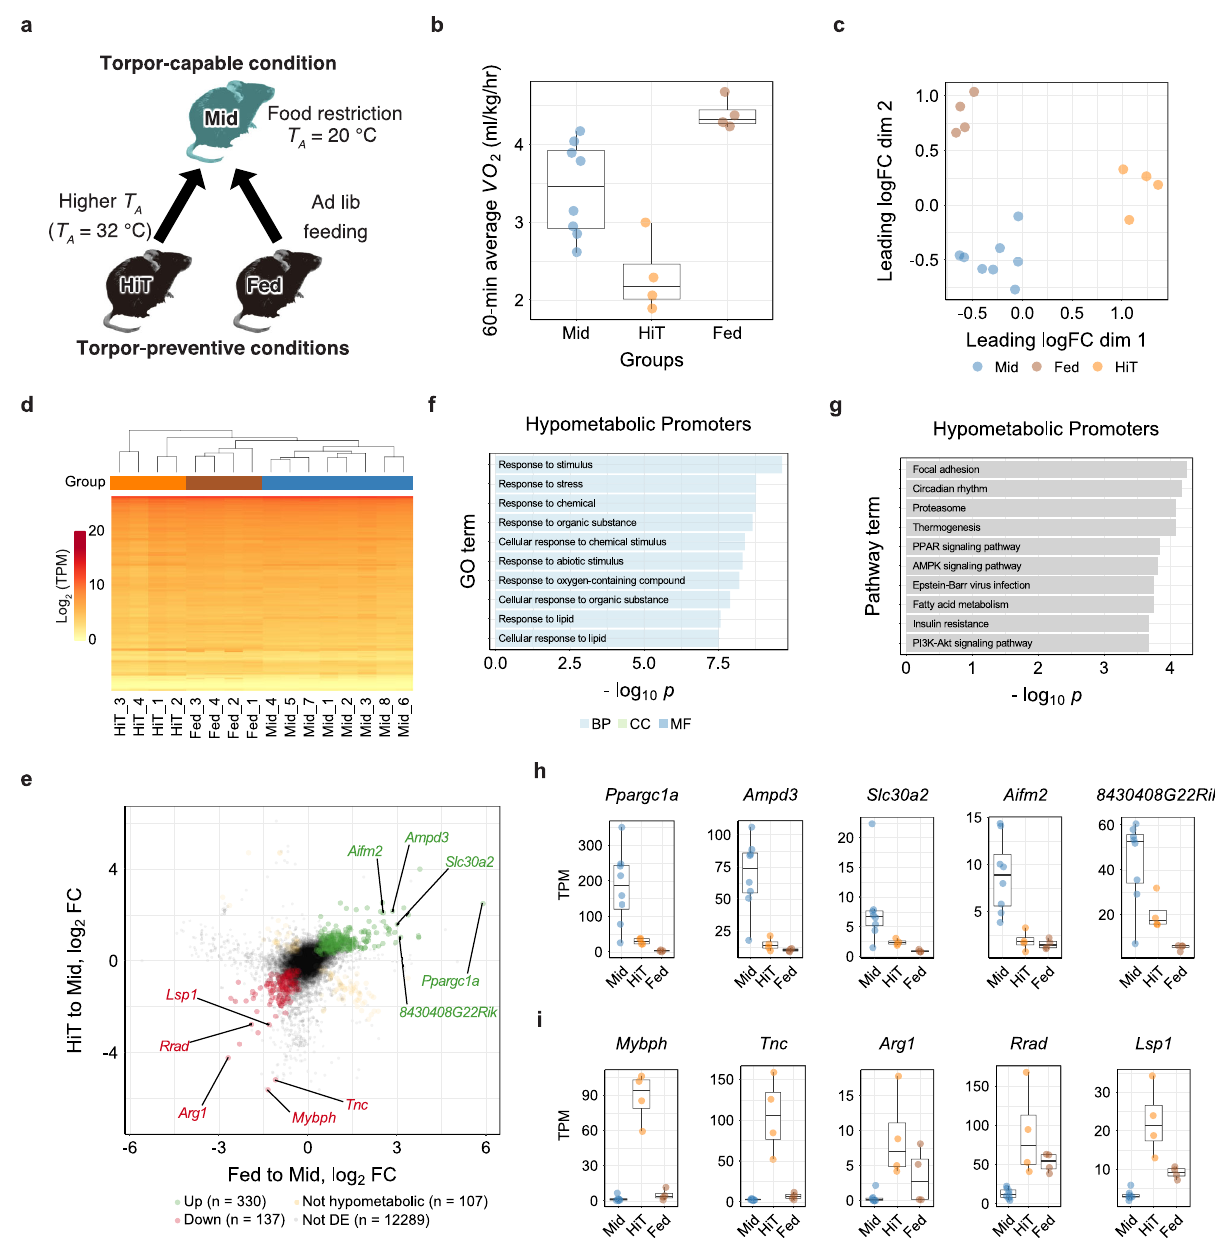
Fig. 2 Torpor Prevention at high T A Revealed Hypometabolism-associated Promoters. a Protocol for detecting the hypometabolic expression by sampling muscles from two groups in which torpor was prevented (HiT and Fed groups, n = 4 for each). For the torpid group, the samples collected in the reversibility test were used (Mid group, n = 8). b Boxplots for the VO 2 of animals at sampling in the hypometabolic experiment. Each dot represents one sample from one animal. During torpor prevention by high- T A (HiT group), the VO 2 was lower than in the Mid group, and when torpor was prevented by food administration (Fed group), VO 2 was higher than in the Mid group. c MDS plot of the TSS-based distance in the hypometabolic experiment. Each dot represents one sample from one animal. The Mid, Fed, and HiT groups were clustered separately. d Hierarchical clustering heatmap based on TPM of the TSS detected in the hypometabolic experiment. The group colors are denoted in ( c ). e Distribution of CAGE clusters according to the fold-change in TPM of the HiT to Mid and Fed to Mid groups. The top fi ve up- and down-regulated hypometabolic promoters that had annotated downstream genes are shown. f The top ten enriched GO terms in the hypometabolic promoters. g The top ten enriched KEGG pathways in the hypometabolic promoters. h , i The top fi ve up- and down-regulated hypometabolic promoters are ordered according to the magnitude of the TPM change. Promoters that had annotated downstream genes are